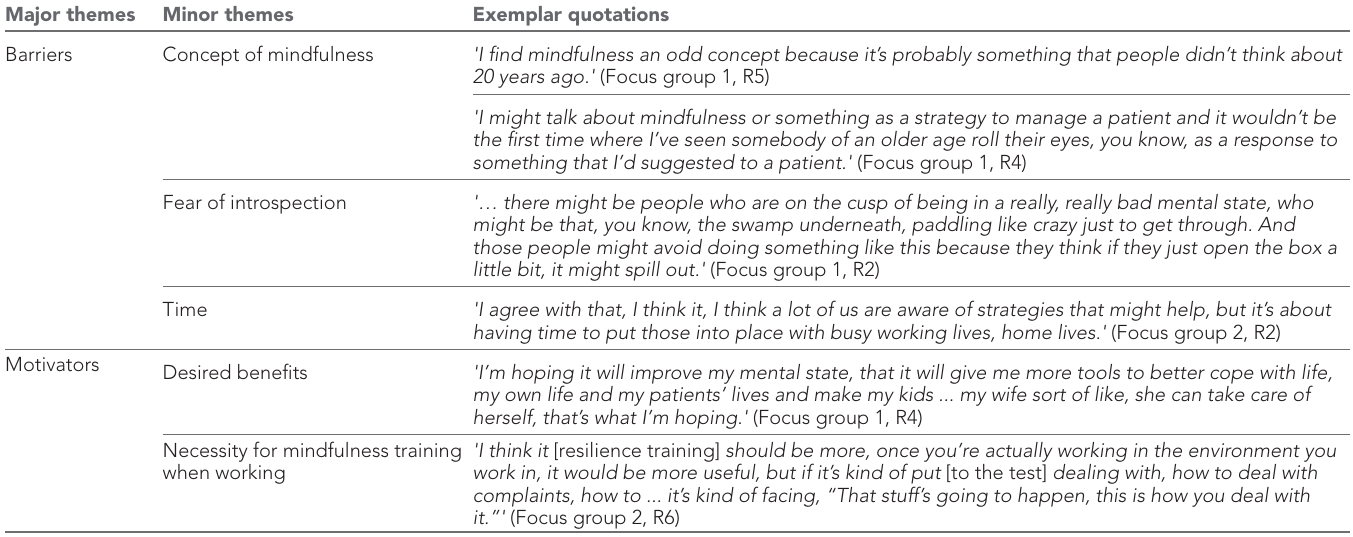
Table 5 Exemplar quotations from participants: perceived barriers and motivations to practising self- care and attending a mindful- ness